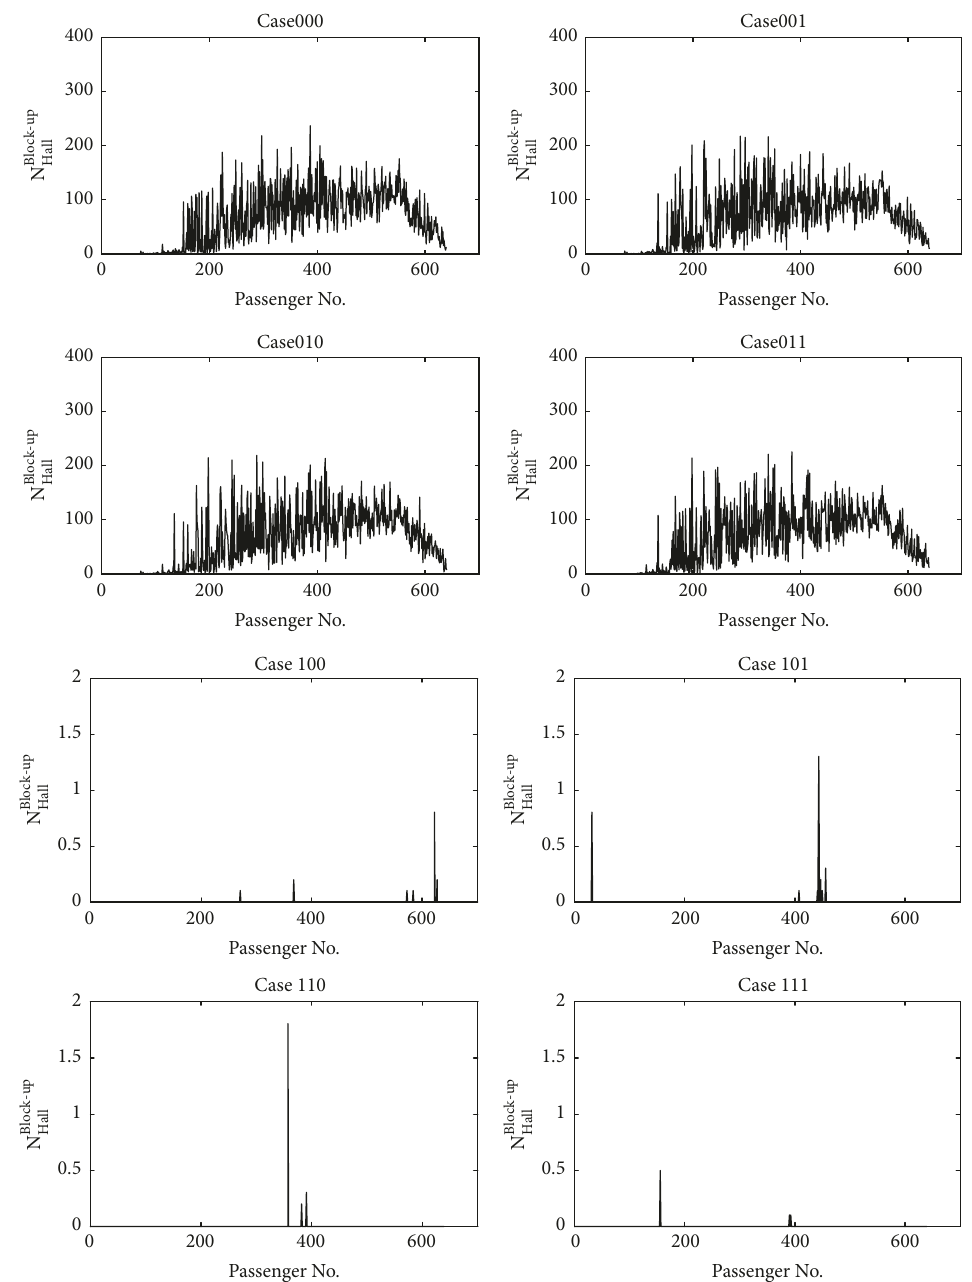
Figure 10: 𝑁 Block-up Hall under the eight